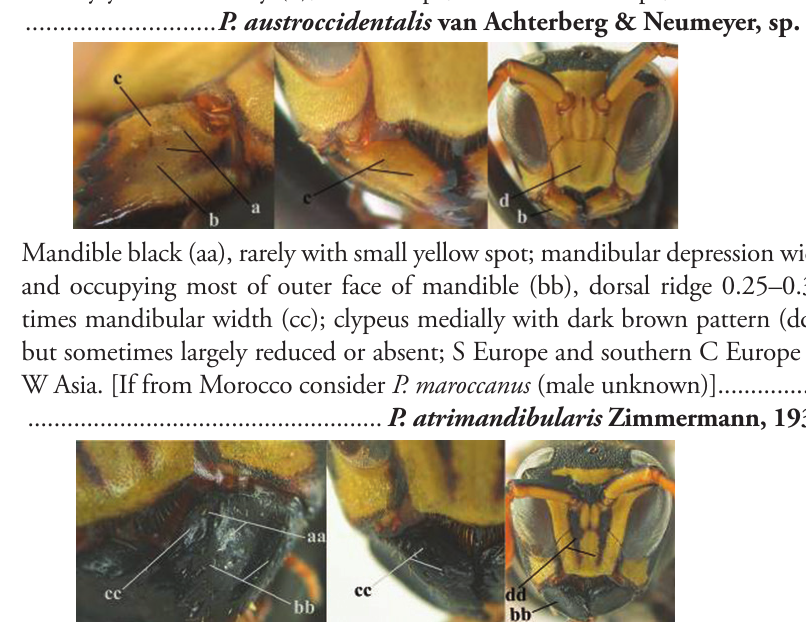
Mandible mainly yellow, except for its more or less darkened margins (a); mandibular depression shorter and occupying less than half of outer face of mandible (b), dorsal ridge at least 0.33 times as wide as mandible (c); clypeus entirely yellow medially (d); SW Europe, southern C Europe, NW Africa ....